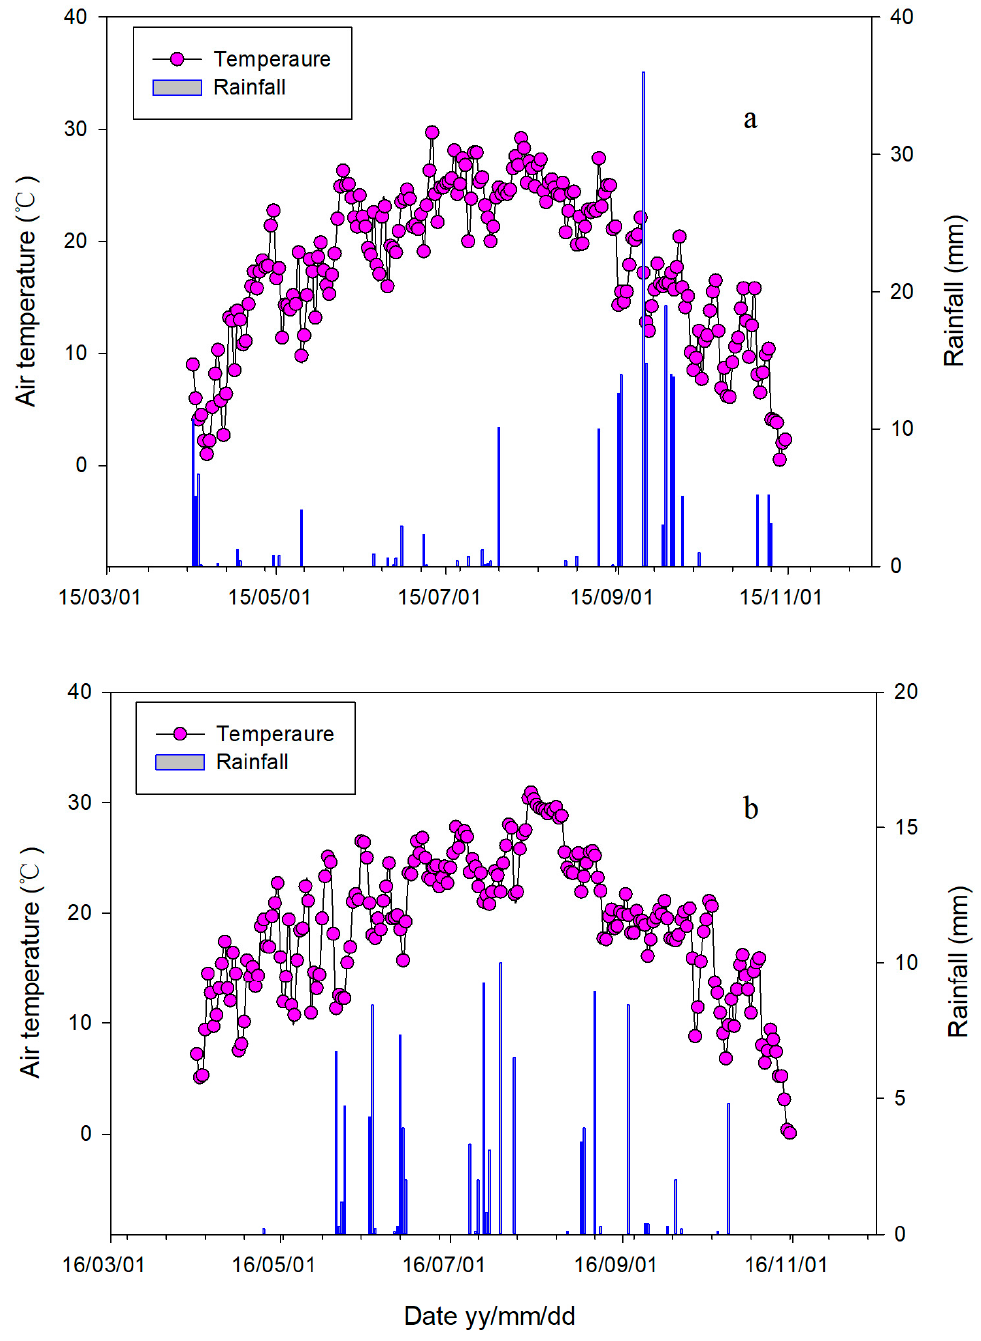
Figure 1. Changes in daily average temperature and precipitation ( a ) for 2015 and ( b ) for 2016.